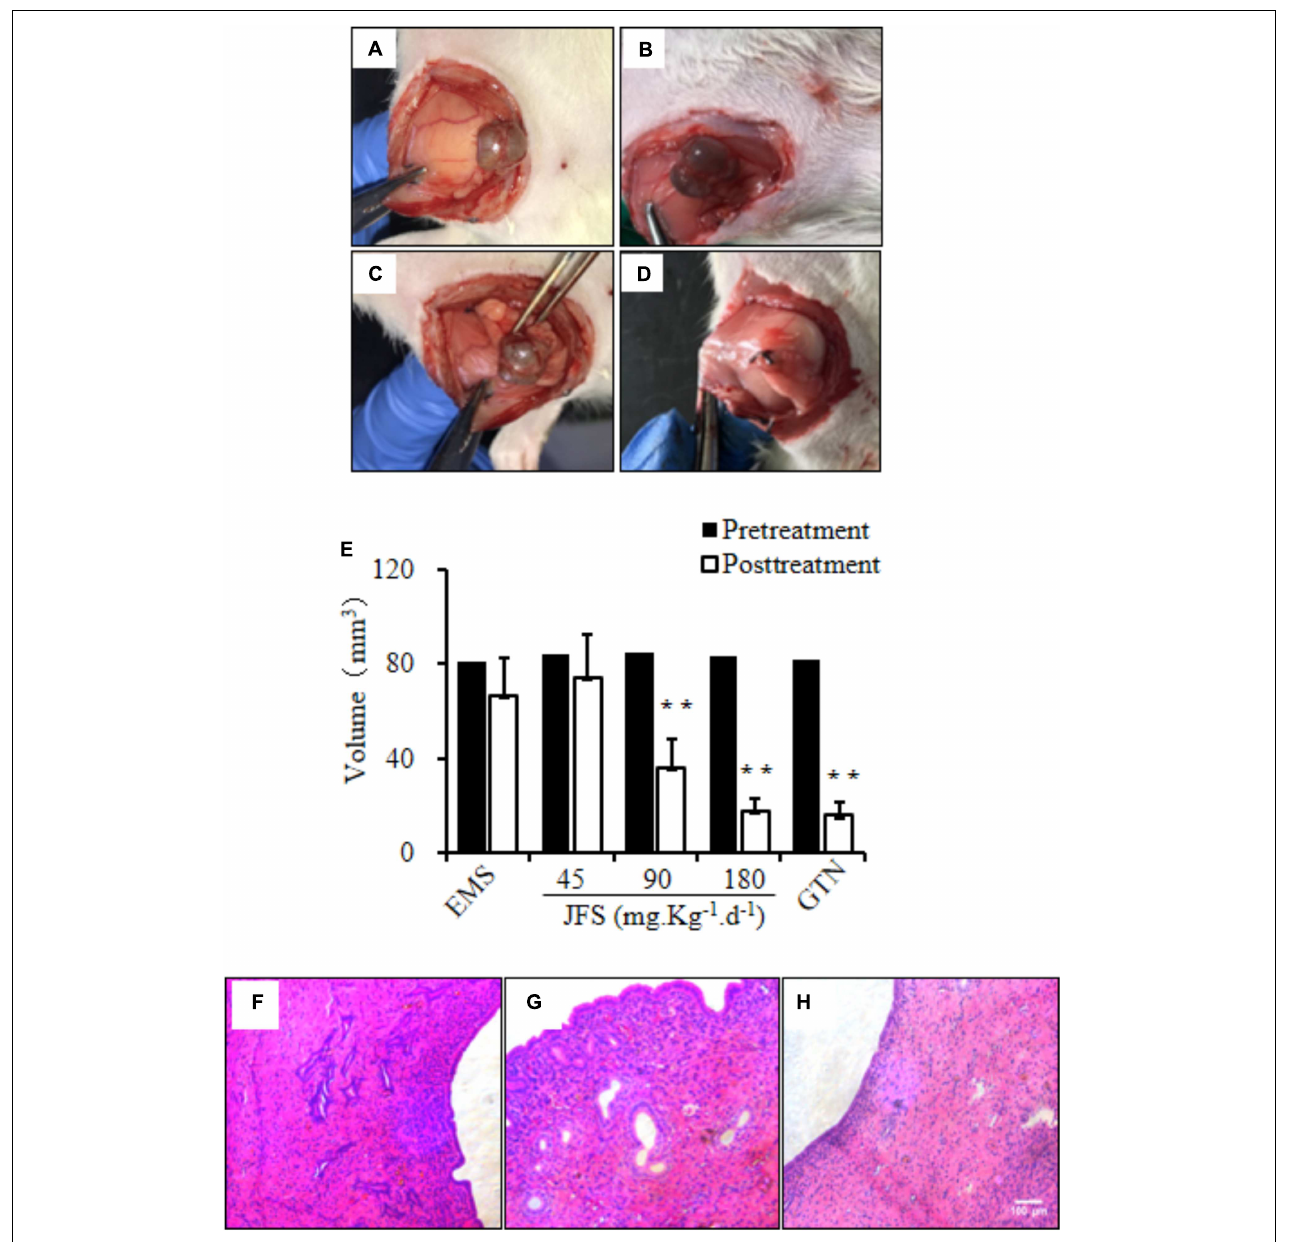
FIGURE 5 | Regulation of JFS on volume and morphology of ectopic endometrium. The ectopic endometrium were observed before and after administration for 28 days in EMS group (A,B) and 180 mg . kg - 1 . d - 1 JFS (C,D) . (E) The volume of ectopic endometrium were detected by Vernier caliper in rat endometriosis model. The morphological change of structure were found in eutopic endometrium in control (F) , ectopic endometrium in EMS (G) , and 180 mg . kg - 1 . d - 1 JFS (H) in H&E staining. ∗∗ P < 0.01 to pretreatment. Columns, mean ( n = 6). Bars, SD. Magnification, × 100. EMS, endometriosis; JFS, Jiawei Foshou San ; GTN, gestrinone.